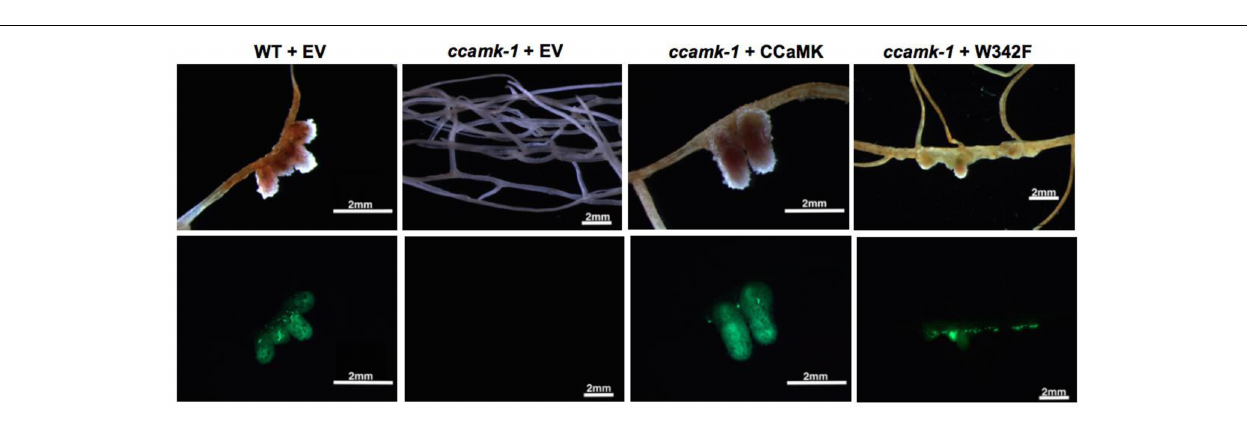
FIGURE 4 | W342F mutation resulted in altered nodule development. Root phenotypes were observed for each construct. Upper: Bright field picture. Lower: GFP fluorescent image of bacteria established in the nodule structure (green color). The W342F mutant complemented ccamk-1 for root nodule